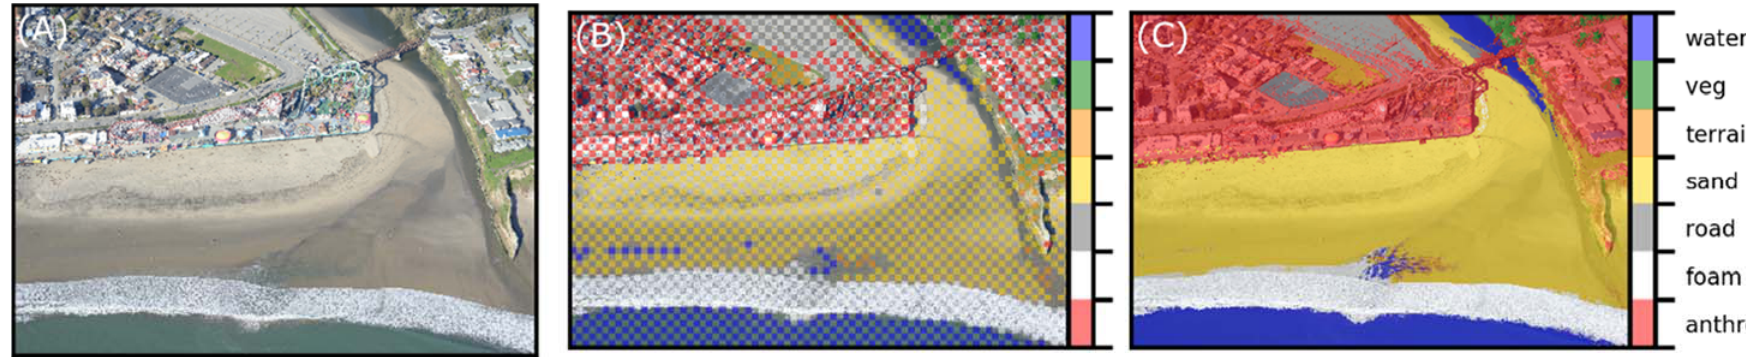
Figure 2. Application of the unsupervised CRF for pixelwise classification, based on unary potentials of regions of the image classified using a DCNN. From left to right, ( A ) the input image, ( B ) the DCNN ‐ estimated sparse labels, and ( C ) the resulting CRF ‐ predicted pixelwise ‐ labeled image. Example image as in Figure 1.